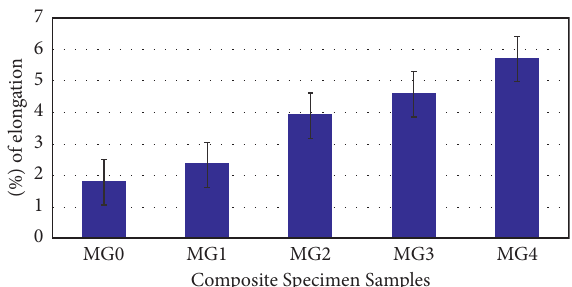
Figure 5: Variation on elongation percentage of composite specimens.